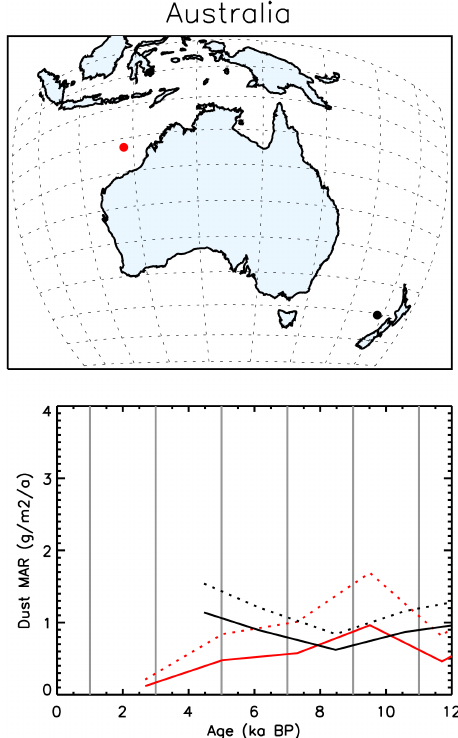
Figure 13. Same as Fig. 6, the Australian